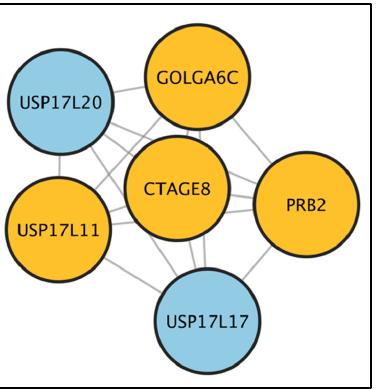
Figure 7. Enriched networks of highly variable, patient-specific genes in long-term survivors versus deceased patients. Protein-coding network of six significant ( p = 0.11) submodules identified as en- riched in long-term survivors versus deceased TNBC patients; seed genes are shown in orange.